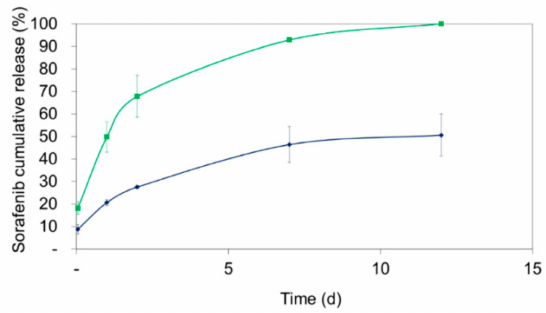
Figure 7. Sorafenib release from Resomer ® RG 752H (green line) and Resomer ® RGP d5055 -sorafenib (PEG-PLGA-SFB) nanocomposites (blue line) in human blood plasma. Data are presented as mean ± SD from three independent samples for each concentration.